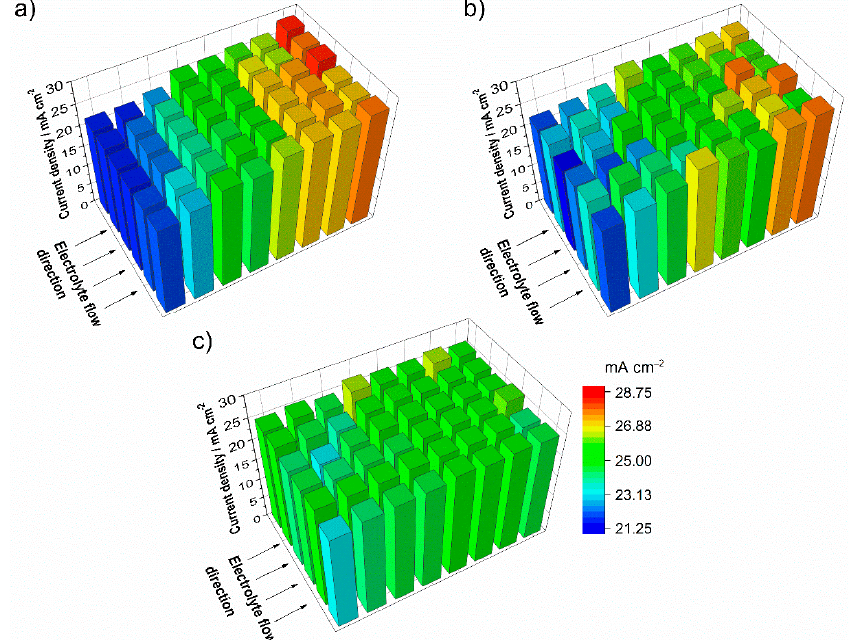
Figure 7. Current density distribution of the positive electrode at initial charging of the battery with 25 mA cm − 2 and an electrolyte flow rate of 2.5 mL min − 1 cm − 2 ( λ > 100 at start) directly after starting around SOC − 50% ( a ), around SOC − 25% ( b ), and at the end of the initialization with SOC 0% ( c ).